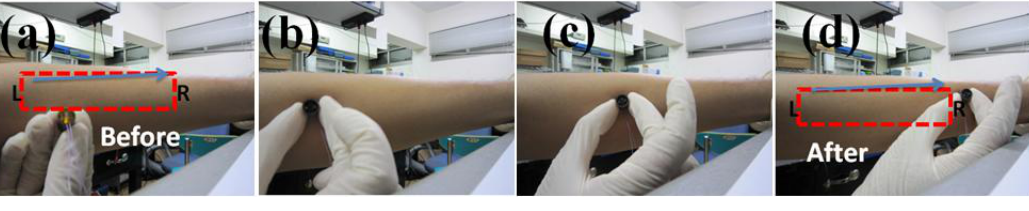
Figure 11. ( a ) The packaged PZT thin film sensor and the area to be touched, ( b ) the packaged tactile sensor touched the human skin, ( c ) the packaged tactile sensor was moved from left to right, ( d ) no scratches were found on the areas the sensor